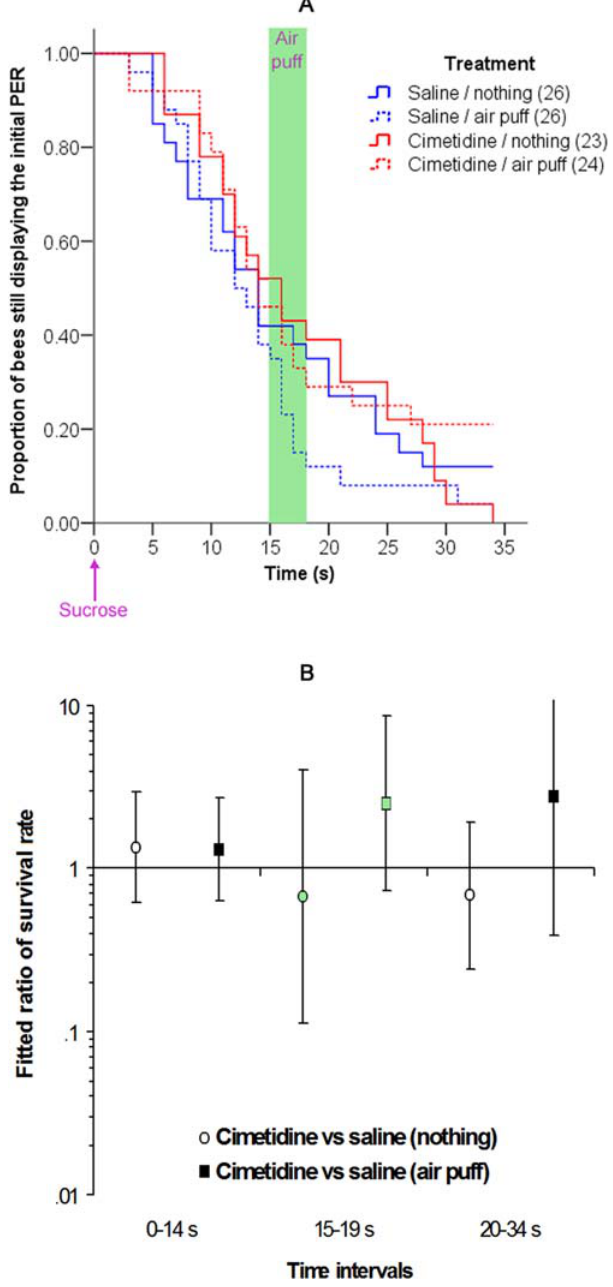
Figure 8. Control for the specificity of cimetidine effect. (A) Proportion of bees treated with 0 or 10 mM cimetidine that continue to release the initial PER as a function of time when presented with nothing or an air puff 15 s after sucrose presentation. Other details are as in Figure 1A. (B) Ratio of the ‘‘survival rate’’ of the PER in the Cox regression for bees treated with 0 mM or 10 mM of cimetidine. The data are presented as in figure 1B.